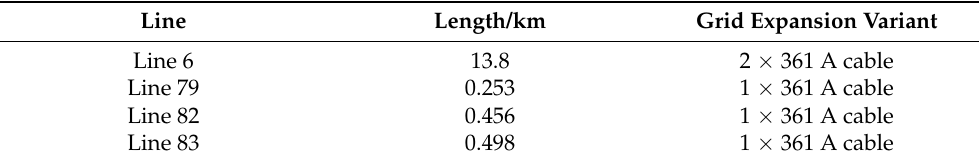
Table 12. Results of the planning variant with underground cables.